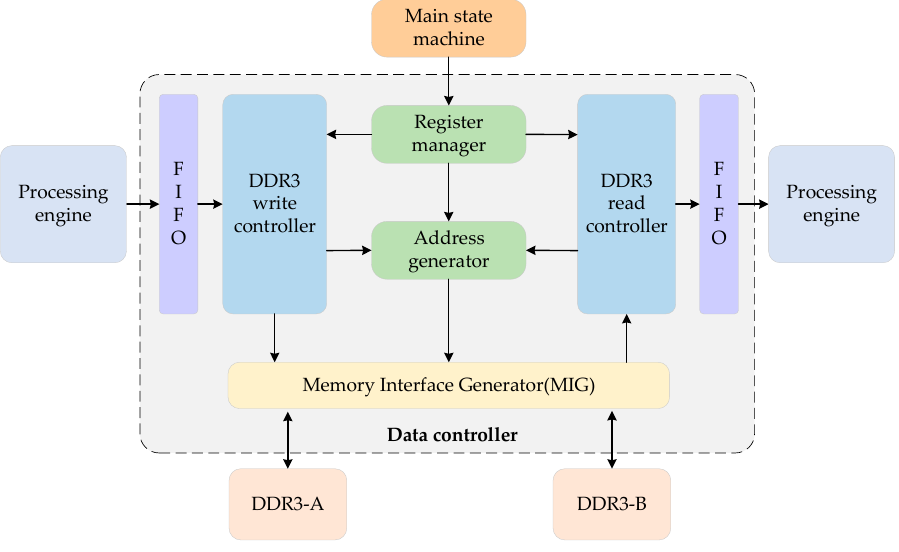
Figure 14. The overall architecture of the proposed data controller.